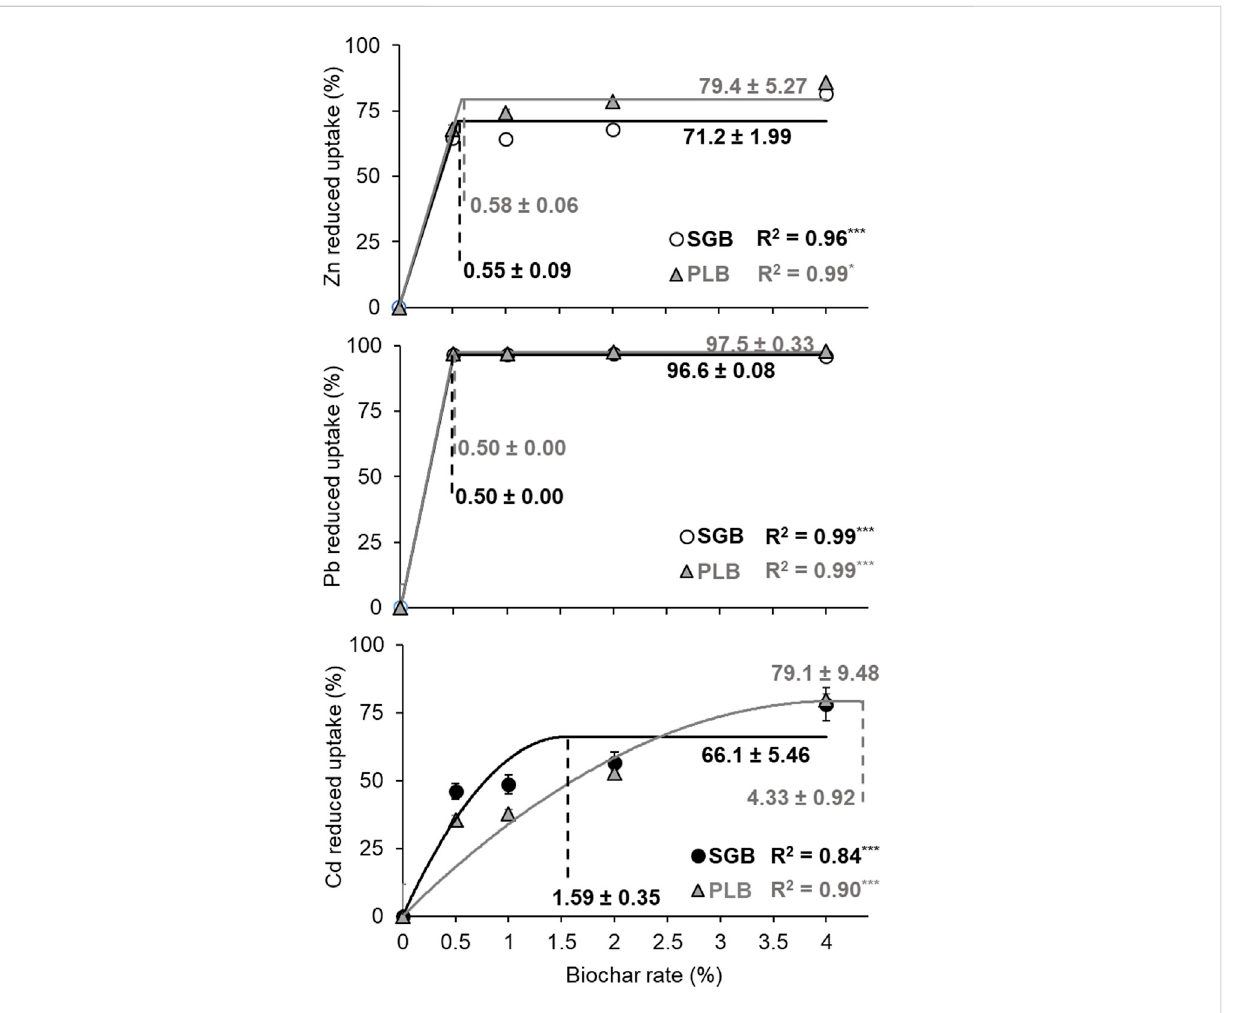
FIGURE 4 The trends of heavy metal uptake reduction by biochar application rates increase. Signi fi cant fi ts to the linear- and quadratic-with-upper-plateau statisticalmodelwereobtained.Barsrepresentthestandarddeviationofthemean( n =3).*: p < 0.05;***: p < 0.001.Valuesfollowedby±arethestandard